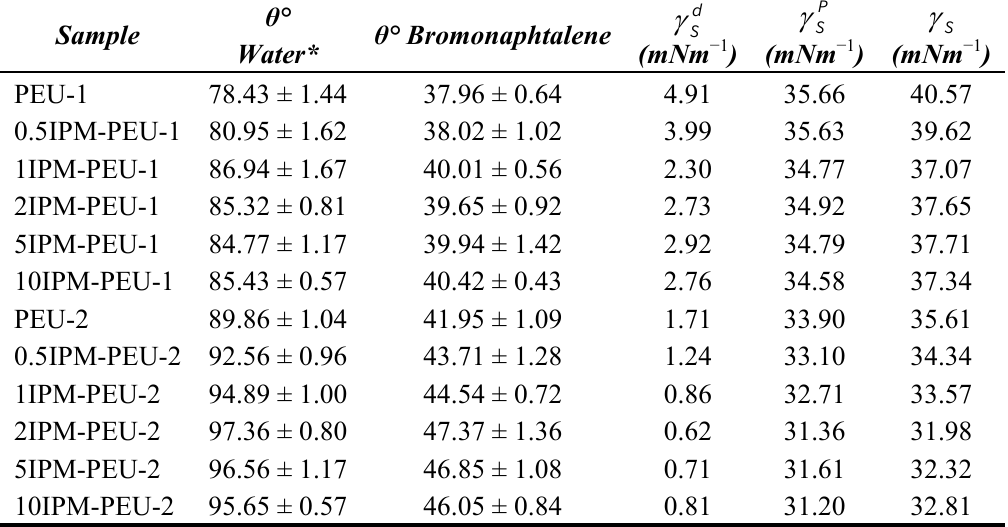
Table 2. Contact angle and surface energy values of IPM modified polyurethanes